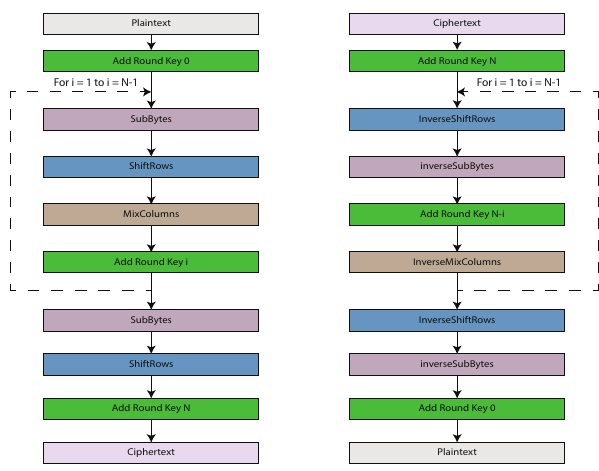
Figure 5: The overall structure of AES, with the en- cryption mode on the left and the decryption mode on the right. For CFB and CTR mode the encryption mode is used both during en- cryption and